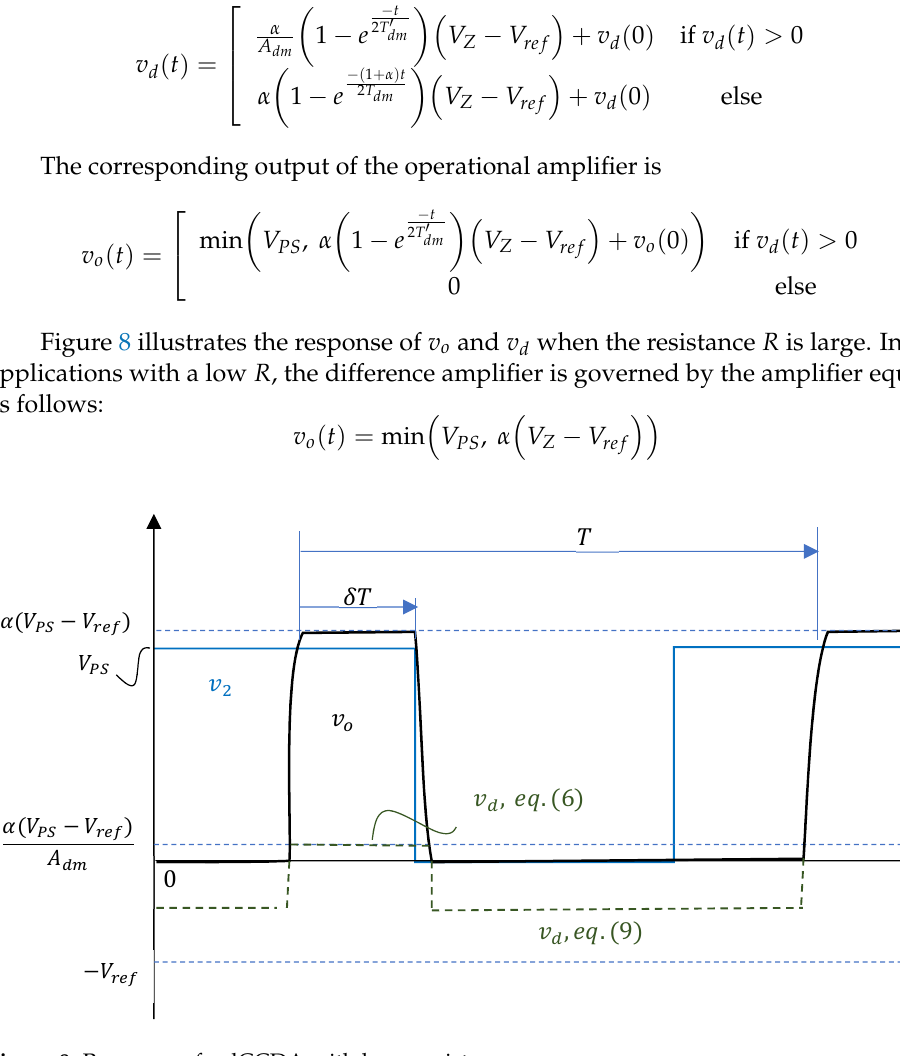
Figure 9. The cCCDA circuit. From the inverting terminal, the following is obtained: 𝑖 (cid:3030)(cid:3040),(cid:3041) =